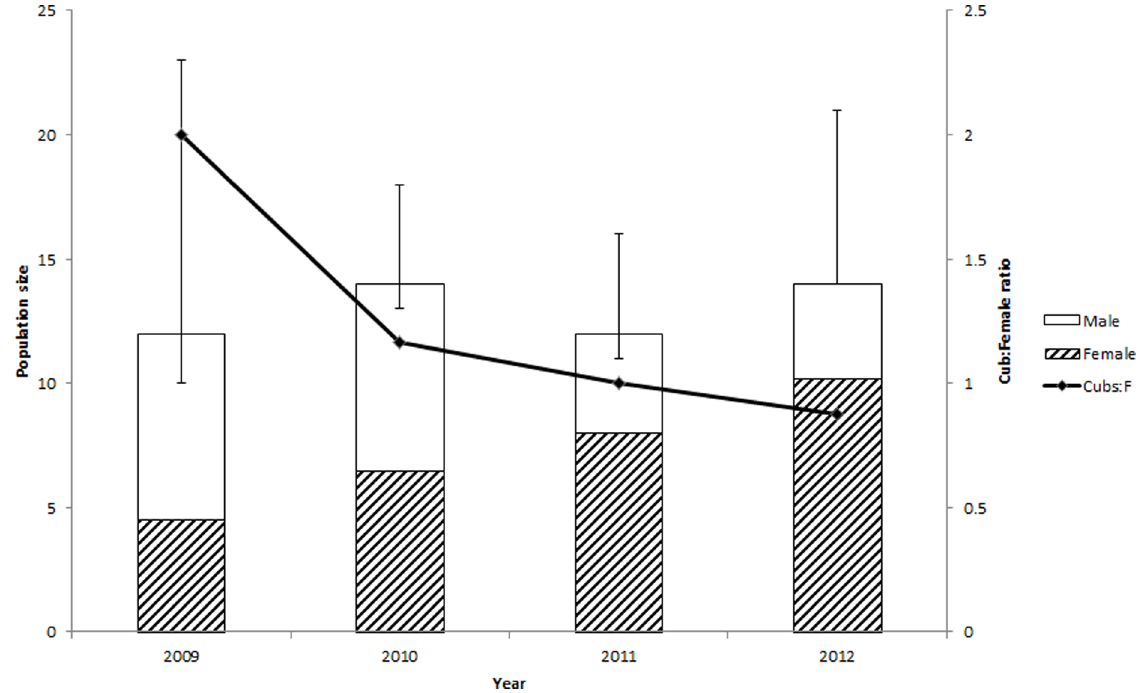
Figure 2. Trends in sex ratio and size of the adult population of snow leopards in the Tost Mountains, South Gobi, Mongolia, between 2009 and 2012. Population size was estimated independently over 4 years using the Jackknife Heterogeneity Model (Mh). Also shown on the secondary axis is the ratio of cubs per adult female. It is worth noting that the number of cubs recorded remained constant even though the ratio declined.